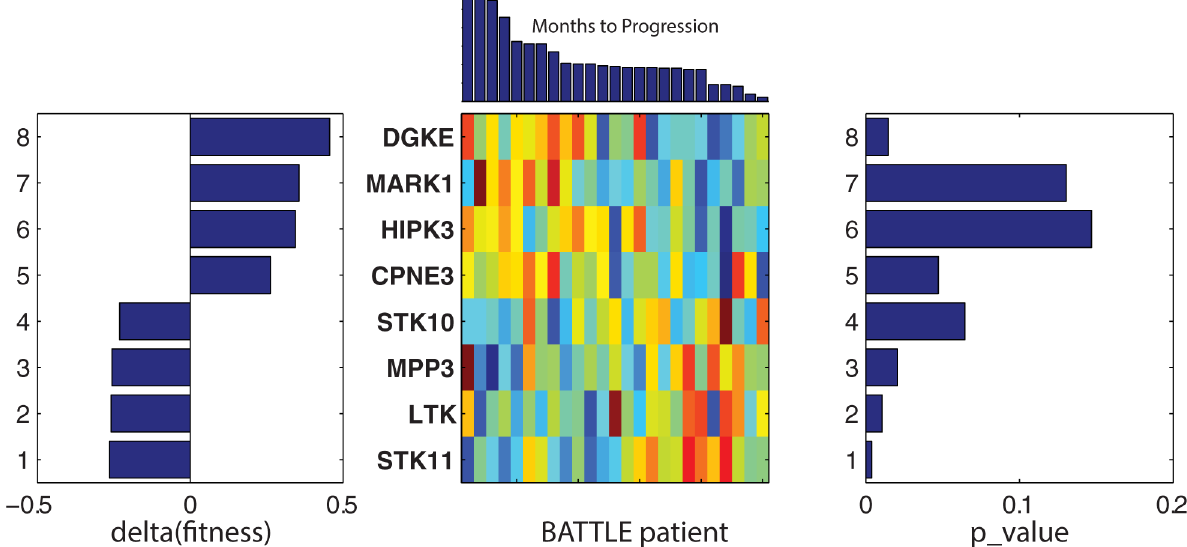
Fig 5. Erlotinib meta-cluster (rows 15–23): The middle panel displays the expression profiles for the genes in meta-claderows 15–23. Expressionsare orderedvertically accordingto their contribution to the total pathwayfitness score, delta(fitness), which is displayedin the left panel.The right panel displaysthe statistical significance(p_value)for either the t-test comparingthe upper and lower 20 th percentilesof patient responses or the correlationof gene expressionto Months to Progression(shown abovethe middle panel).